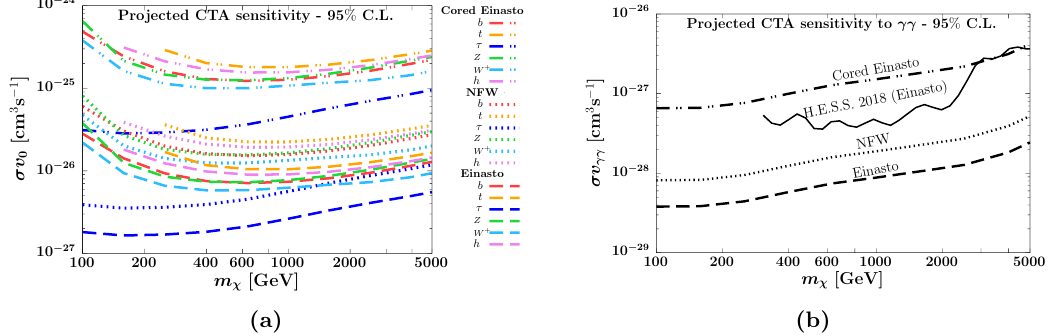
Figure 1. 95% C.L. CTA projected sensitivities to the velocity-weighted annihilation cross section versus DM mass m (cid:31) , derived from observations of the inner Galactic halo assuming 500 hour homogeneous exposure for three separate halo pro(cid:12)les: Cored Einasto (dashed double-dotted), NFW (dotted) and Einasto (dashed lines). (a) The CTA sensitivity is given for the speci(cid:12)c (cid:12)nal states introduced in the text. (b) The CTA sensitivity is derived for a monochromatic (cid:13) line. The solid line represents the current 95% C.L. observed upper limit from H.E.S.S. obtained for the Einasto DM pro(cid:12)le [3]. Line texture is the same as in